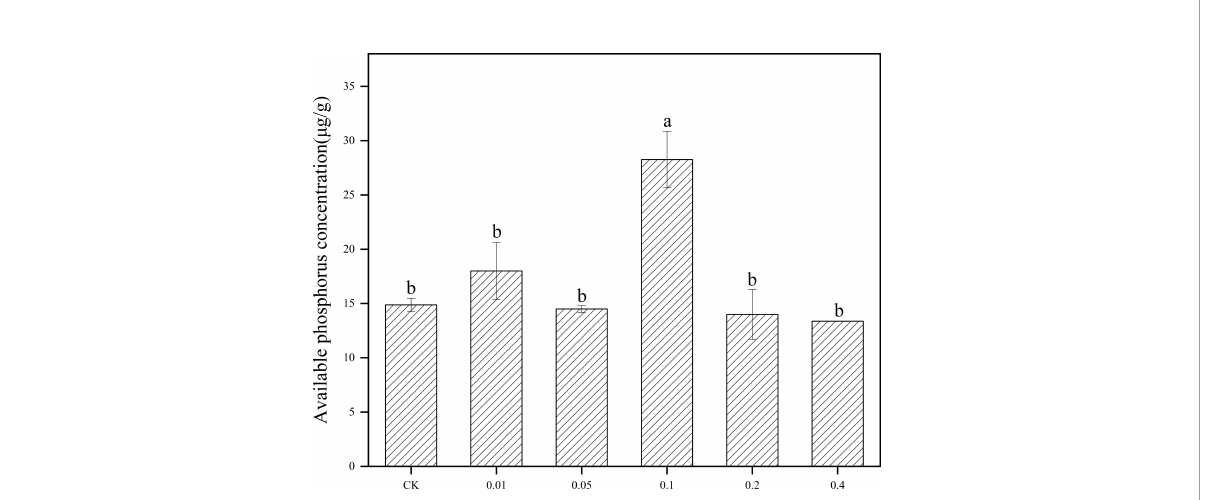
FIGURE 5 Effect of B . frigoritolerans on soil available phosphorus after being treated with different concentration phenol treatments. Different lowercase letters indicate that the same strain with different concentration of phenol treatments has signi fi cant differences at the P < 0.05